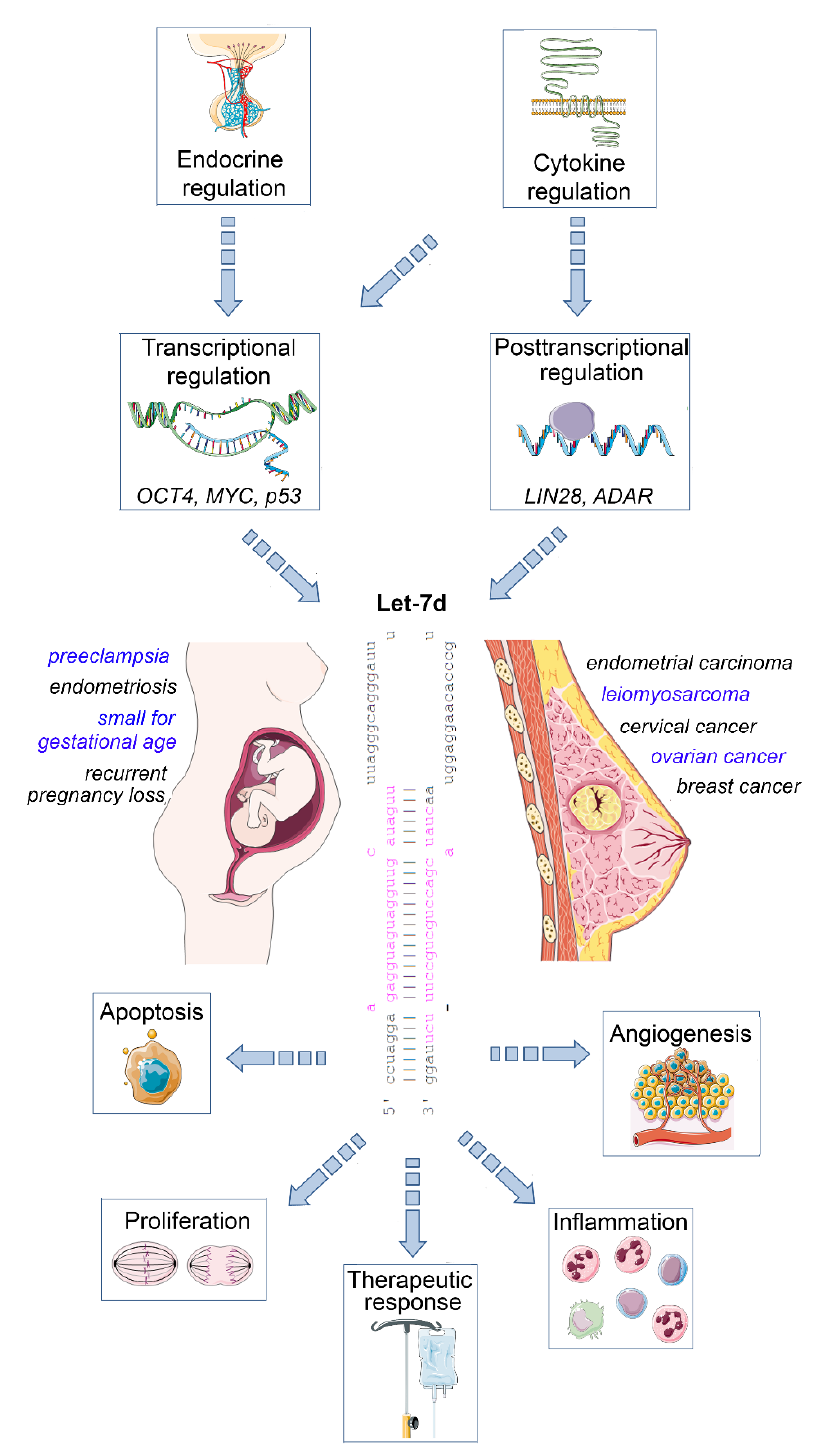
Figure 1. Impact of let-7d on female malignancies and diseases of the female reproductive tract. Let-7d expression is dysregulated in a variety of gynaecological and obstetric disorders. Its expression is regulated in a hormone- and cytokine-dependent manner involving both transcriptional and post- transcriptional mechanisms. Let-7d targets key mRNAs involved in the regulation of cell proliferation, apoptosis, angiogenesis and immune cell function, thereby modulating disease progression and therapeutic response. See text for details. The Let-7d sequence was retrieved from miRbase [24]. This figure was designed using elements of the free web resource Smart Servier Medical Art (https://smart.servier.com/ (accessed on 1 June 2021)).